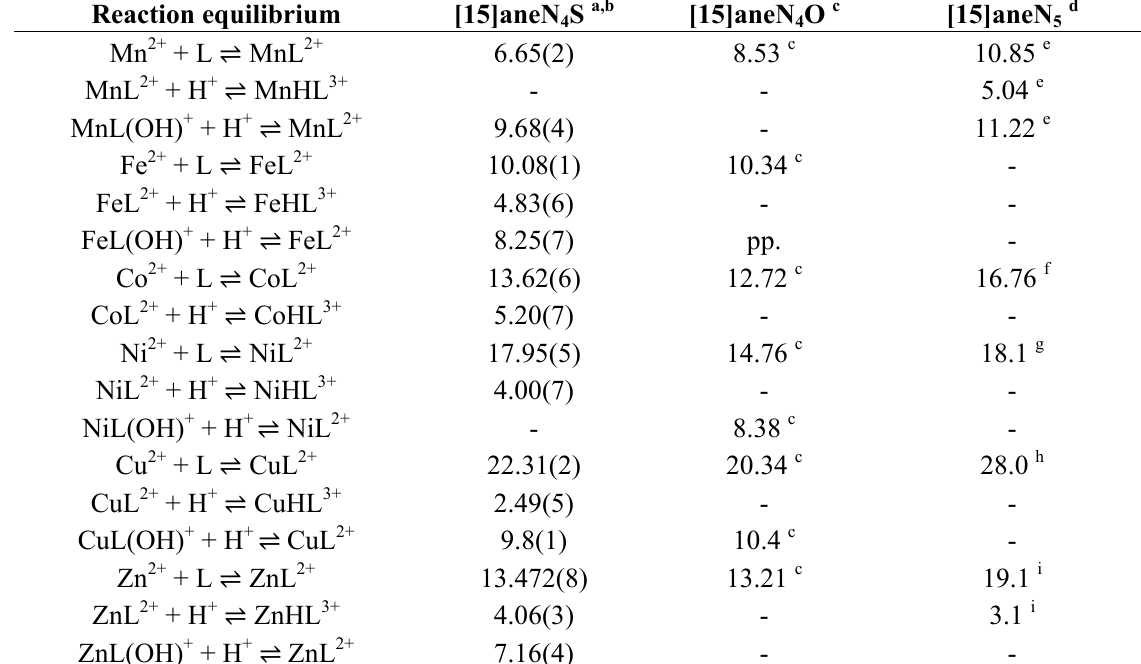
Table 2. Stepwise stability constants (log units) of the complexes of [15]aneN [15]aneN O and [15]aneN with different metal 4 5